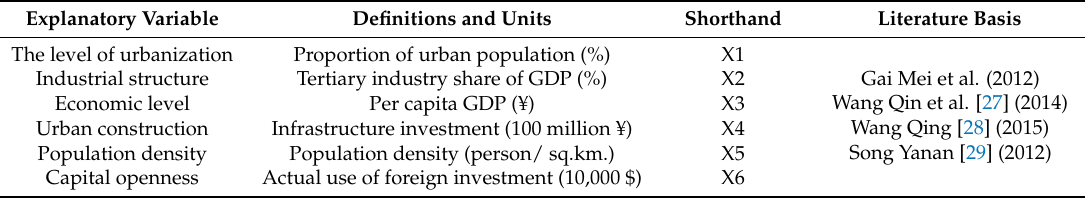
Table 6. Factors affecting the EGE of the Yangtze River urban agglomeration.